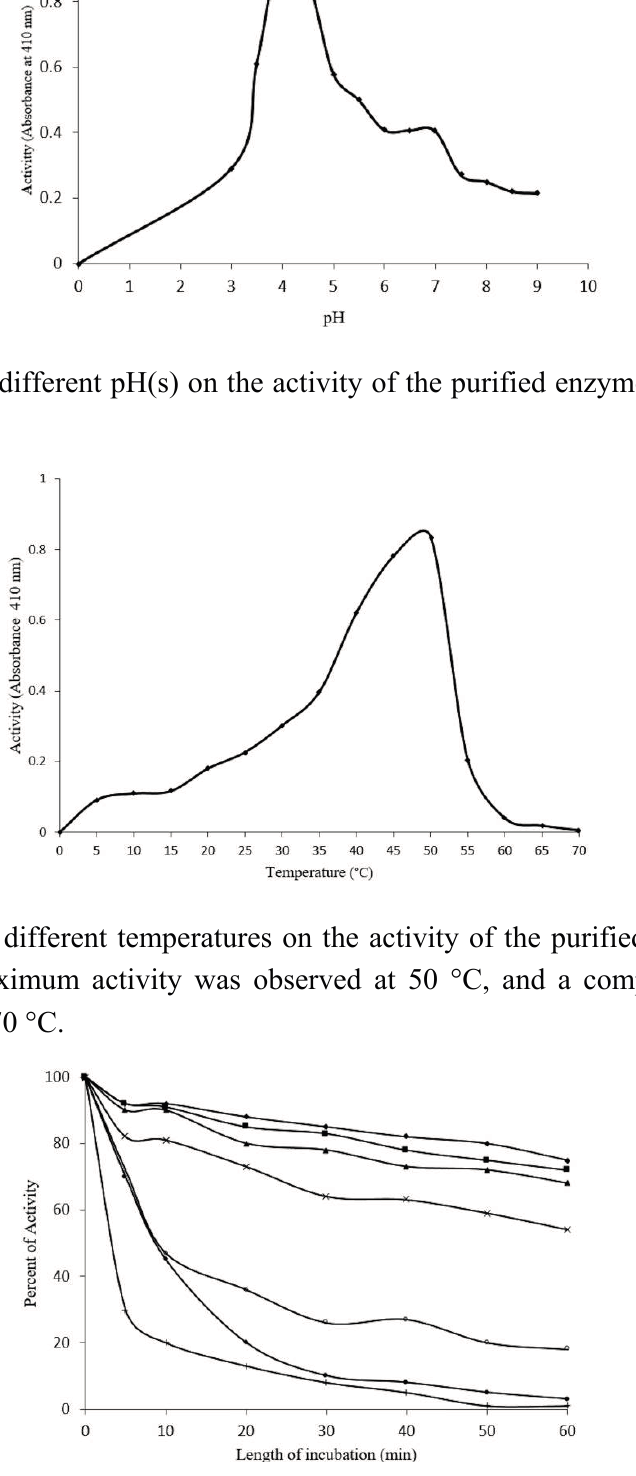
Figure 7. Thermostabilty of β -glucosidase (1 mg/mL) in Sechium edule vs. time of incubation (10 min intervals) at pH 5.0. Temperatures were ♦─♦ 30 °C, ■─■ 35 °C, ▲─▲ 40 °C, x ─ x 45 °C, ○─○ 50 °C, ●─● 55 °C, + ─ + 60 °C. Increasing temperatures and time of incubation lead to a complete loss of activity. (Please provide us original figures with high